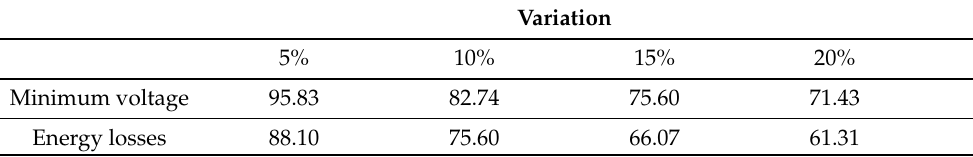
Table 11. Percentage of predicted results with AMD values between 0% and